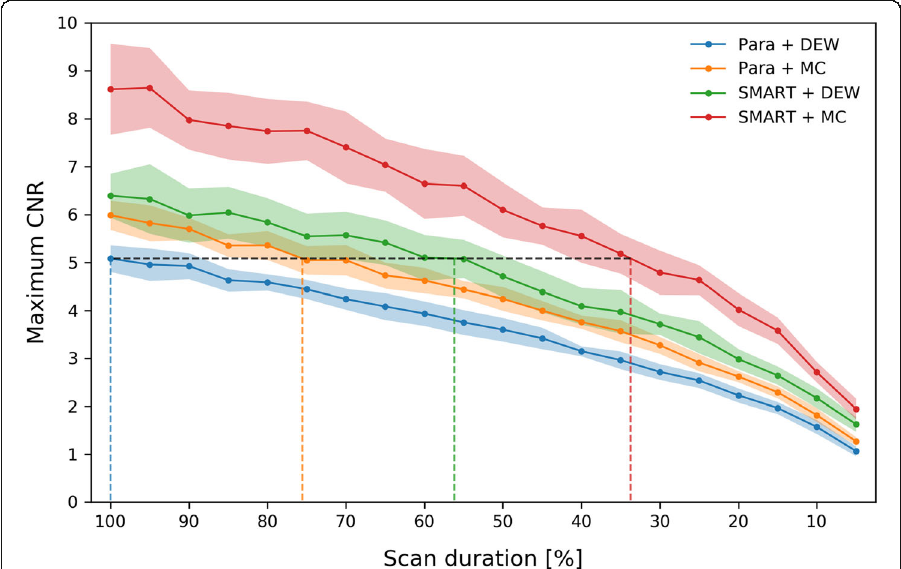
Fig. 8 The maximum CNR, as a function of the scan duration. The black dashed line is drawn at the maximum CNR achieved by the parallel-hole collimator with dual-energy window scatter correction. The dashed lines in color are drawn at the scan durations at which the same maximum CNR is achieved for the other collimator and scatter correction combinations. The shaded areas represent the standard deviation over the 20 noise